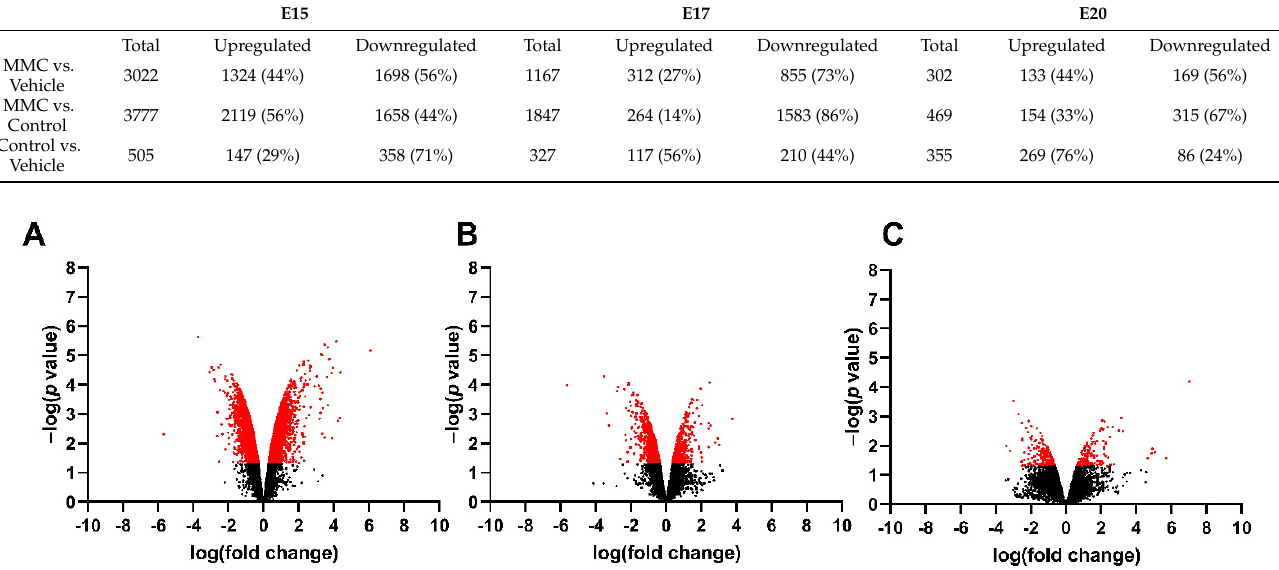
Figure 2. Volcano plot illustrating RNA-seq data of fetal spinal cords isolated from MMC and vehicle at ( A ) E15, ( B ) E17, and ( C ) E20. Red identifies genes that were greater than 1.5-fold change and p < 0.05.